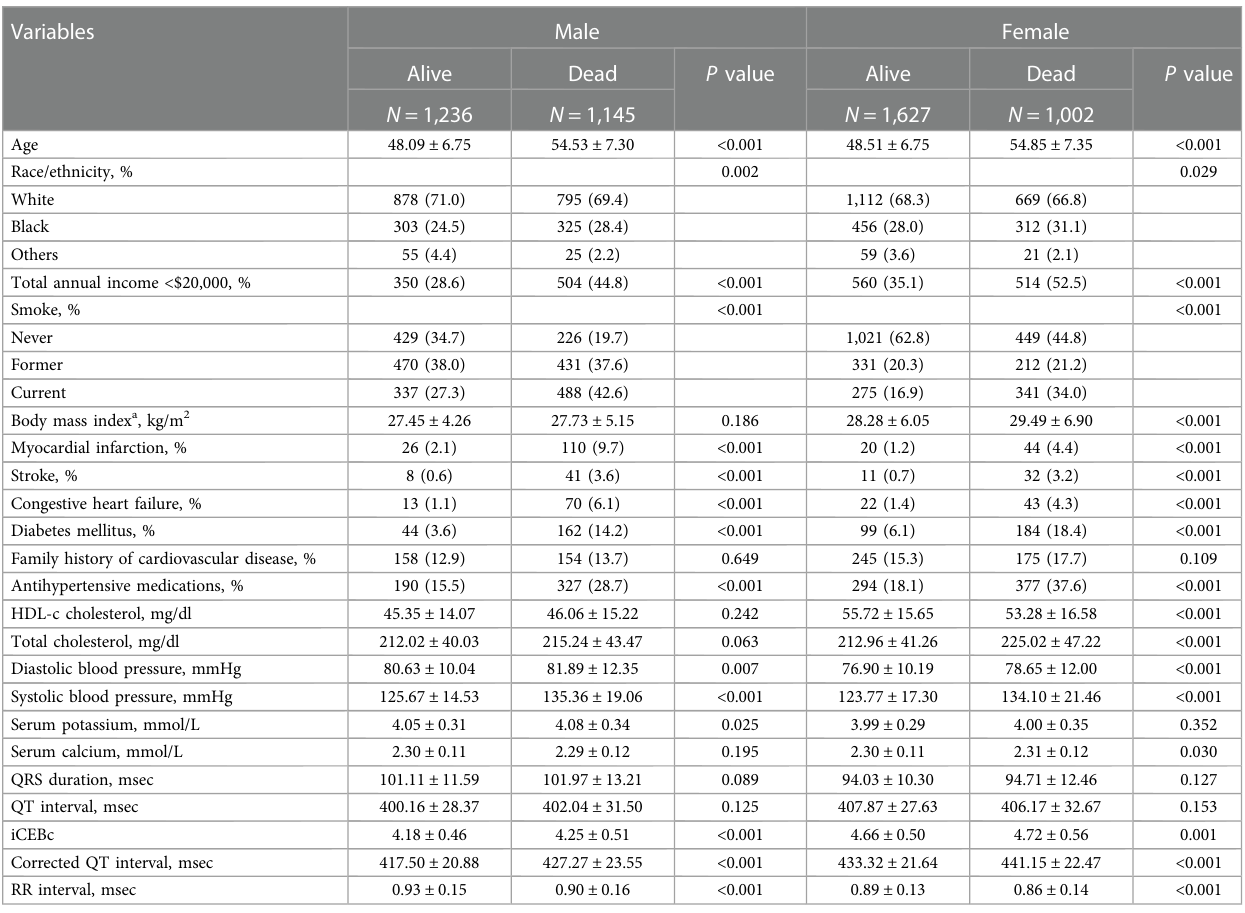
TABLE 1 Baseline characteristics of US